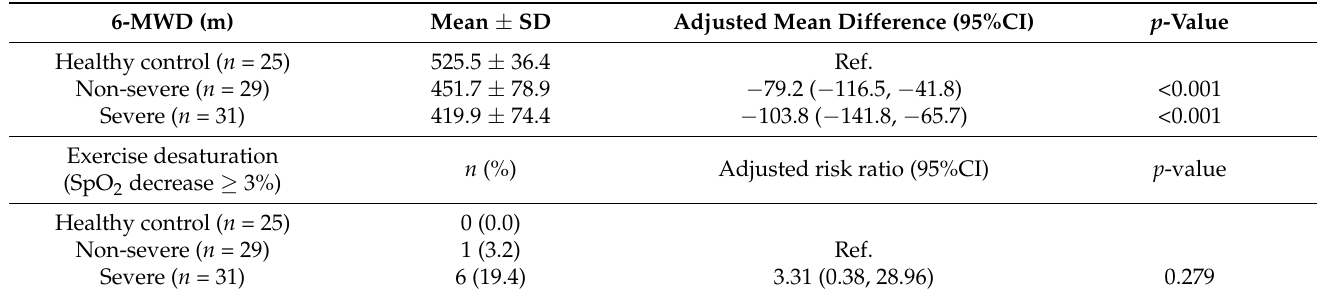
Table 8. Exercise capacity and exercise desaturation test at one-month follow-up visit (N =